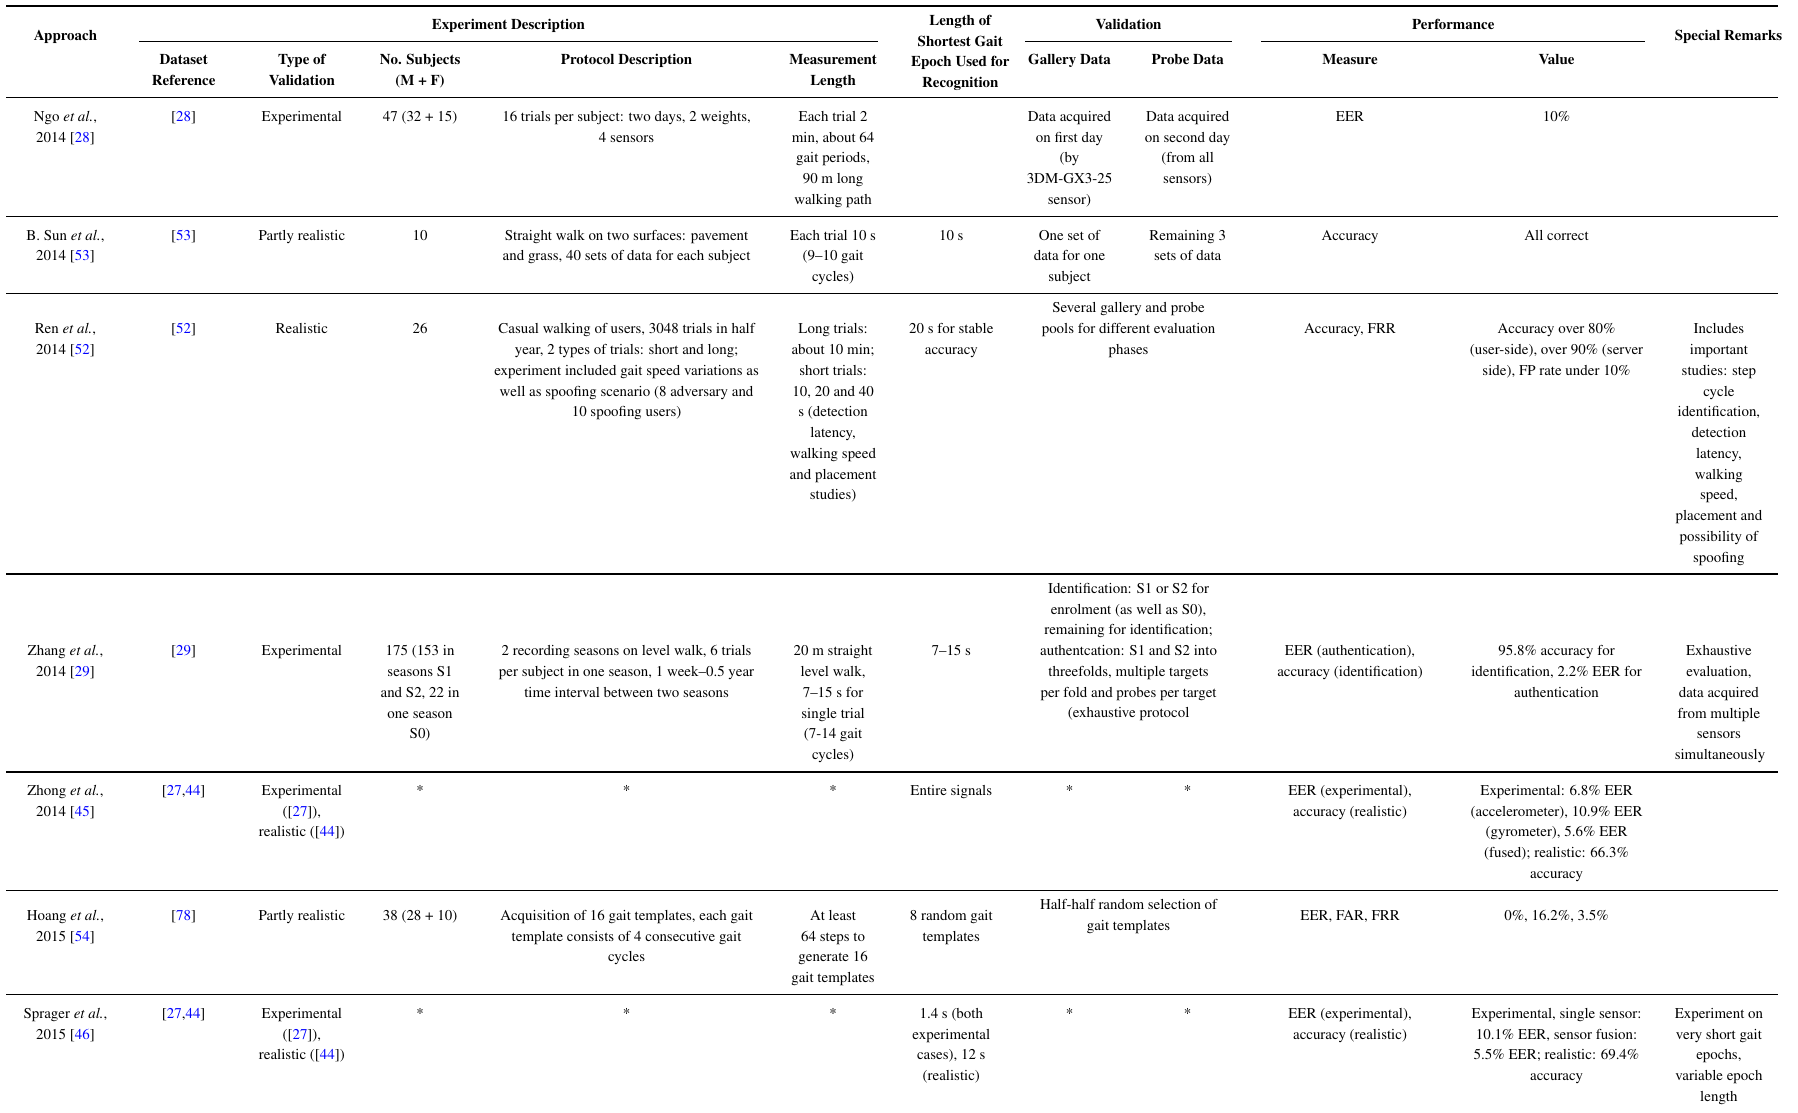
Table 4. Evaluation of representative inertial sensor-based gait recognition approaches (part